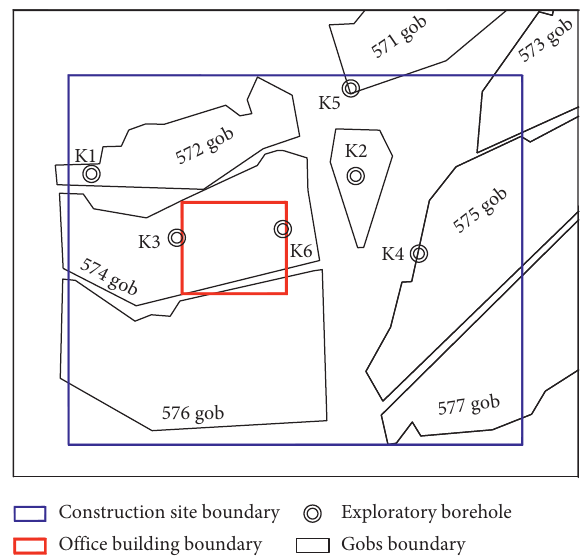
Figure 2: Location of the gobs, construction site, and office building (modified from [13]).